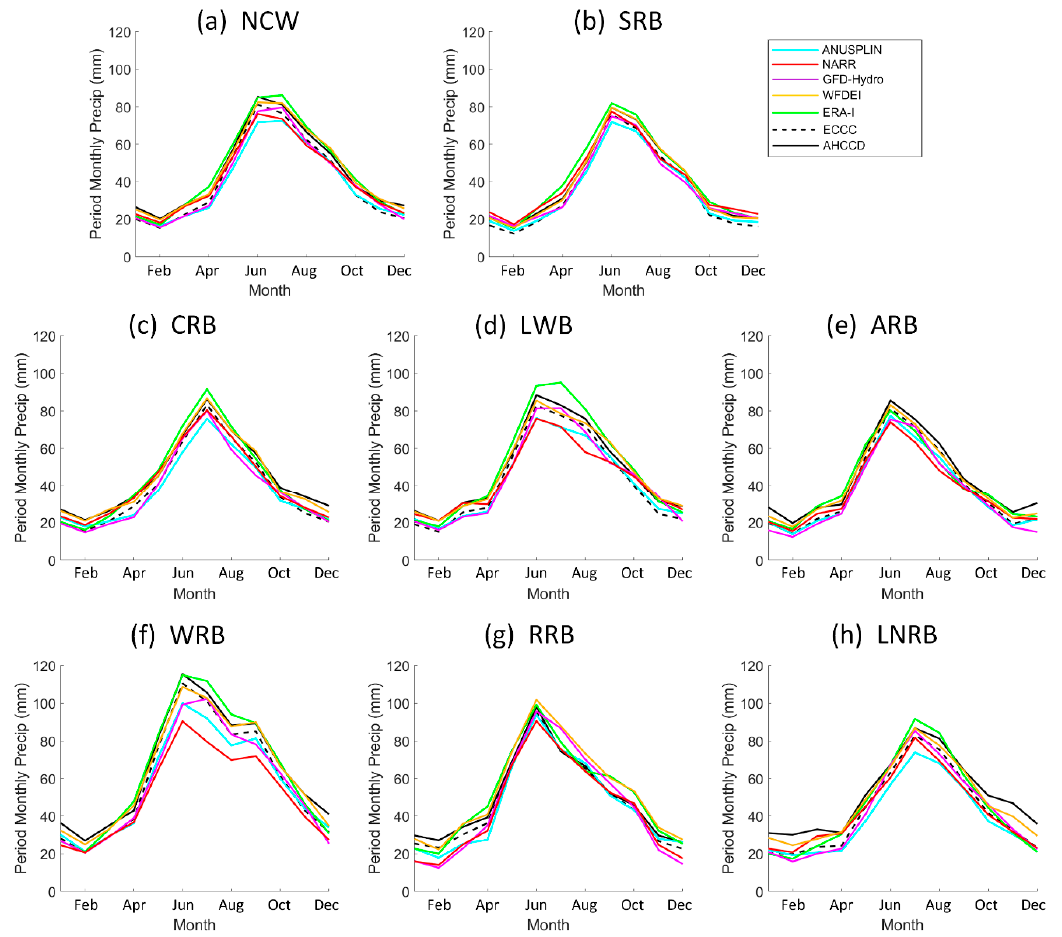
Figure 2. Mean monthly precipitation for 1981–2010, spatially averaged over each of the sub-basins. Aggregations include ( a ) the lumped Nelson–Churchill Watershed (NCW), and the semi-lumped sub-basin aggregations that include: ( b ) the Saskatchewan River Basin (SRB), ( c ) the Churchill River Basin (CRB), ( d ) the Lake Winnipeg Basin (LWB), ( e ) the Assiniboine River Basin (ARB), ( f ) the Winnipeg River Basin (WRB), ( g ) the Red River Basin (RRB), and ( h ) the Lower Nelson River Basin (LNRB).